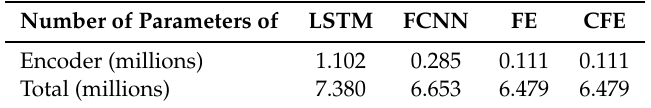
Table 3. Number of internal parameters of the models compared (in millions), considering only the encoder and the entire model (encoder + attention mechanism + decoder). Number of Parameters